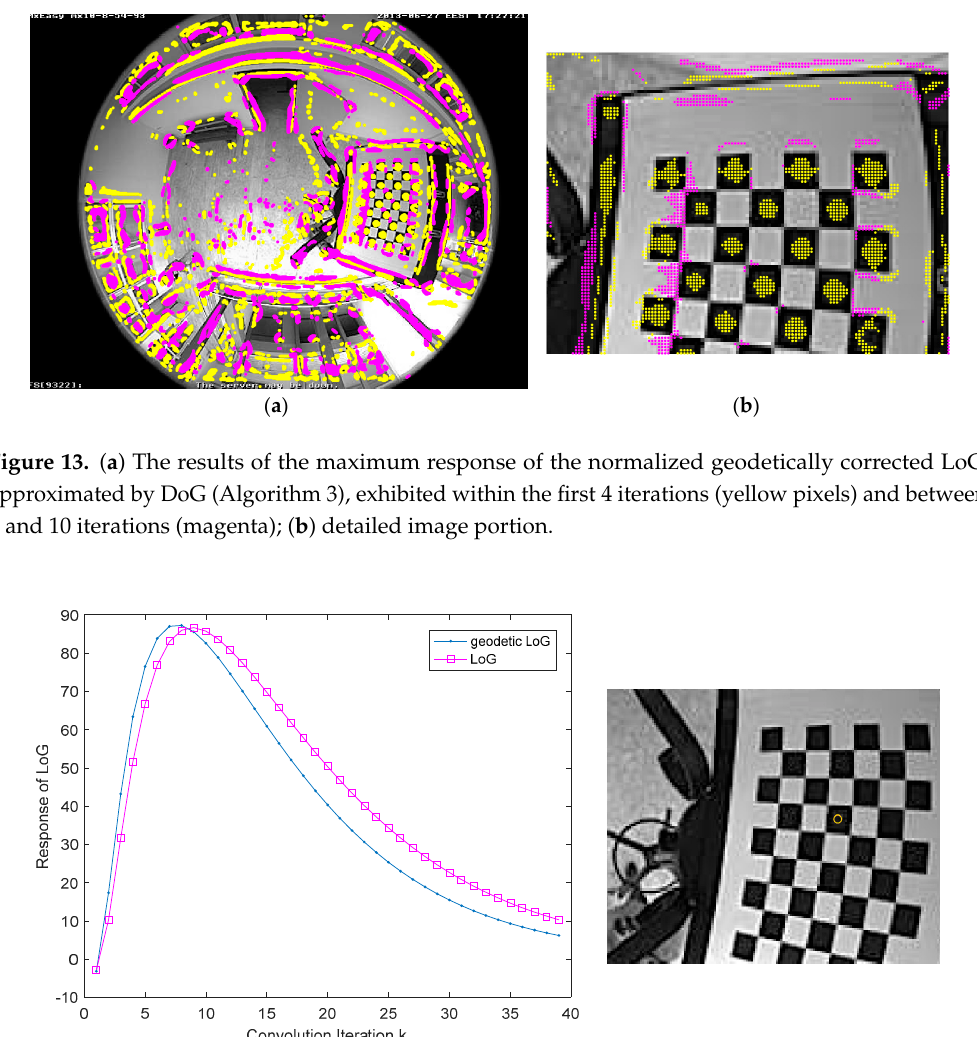
Figure 14. ( a ) The response of the normalized DoG for the pixel shown in ( b ). The small differences between the two curves are evident.